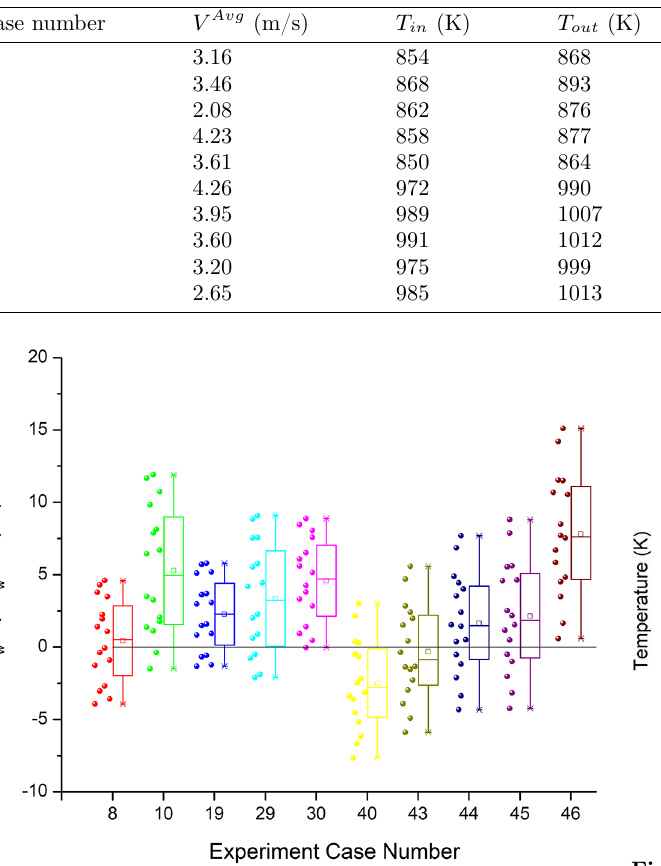
Fig. 6. Axial temperature on the outer wall of the test sec- tion measured with thermocuples in [2] and obtained in the simulations for case